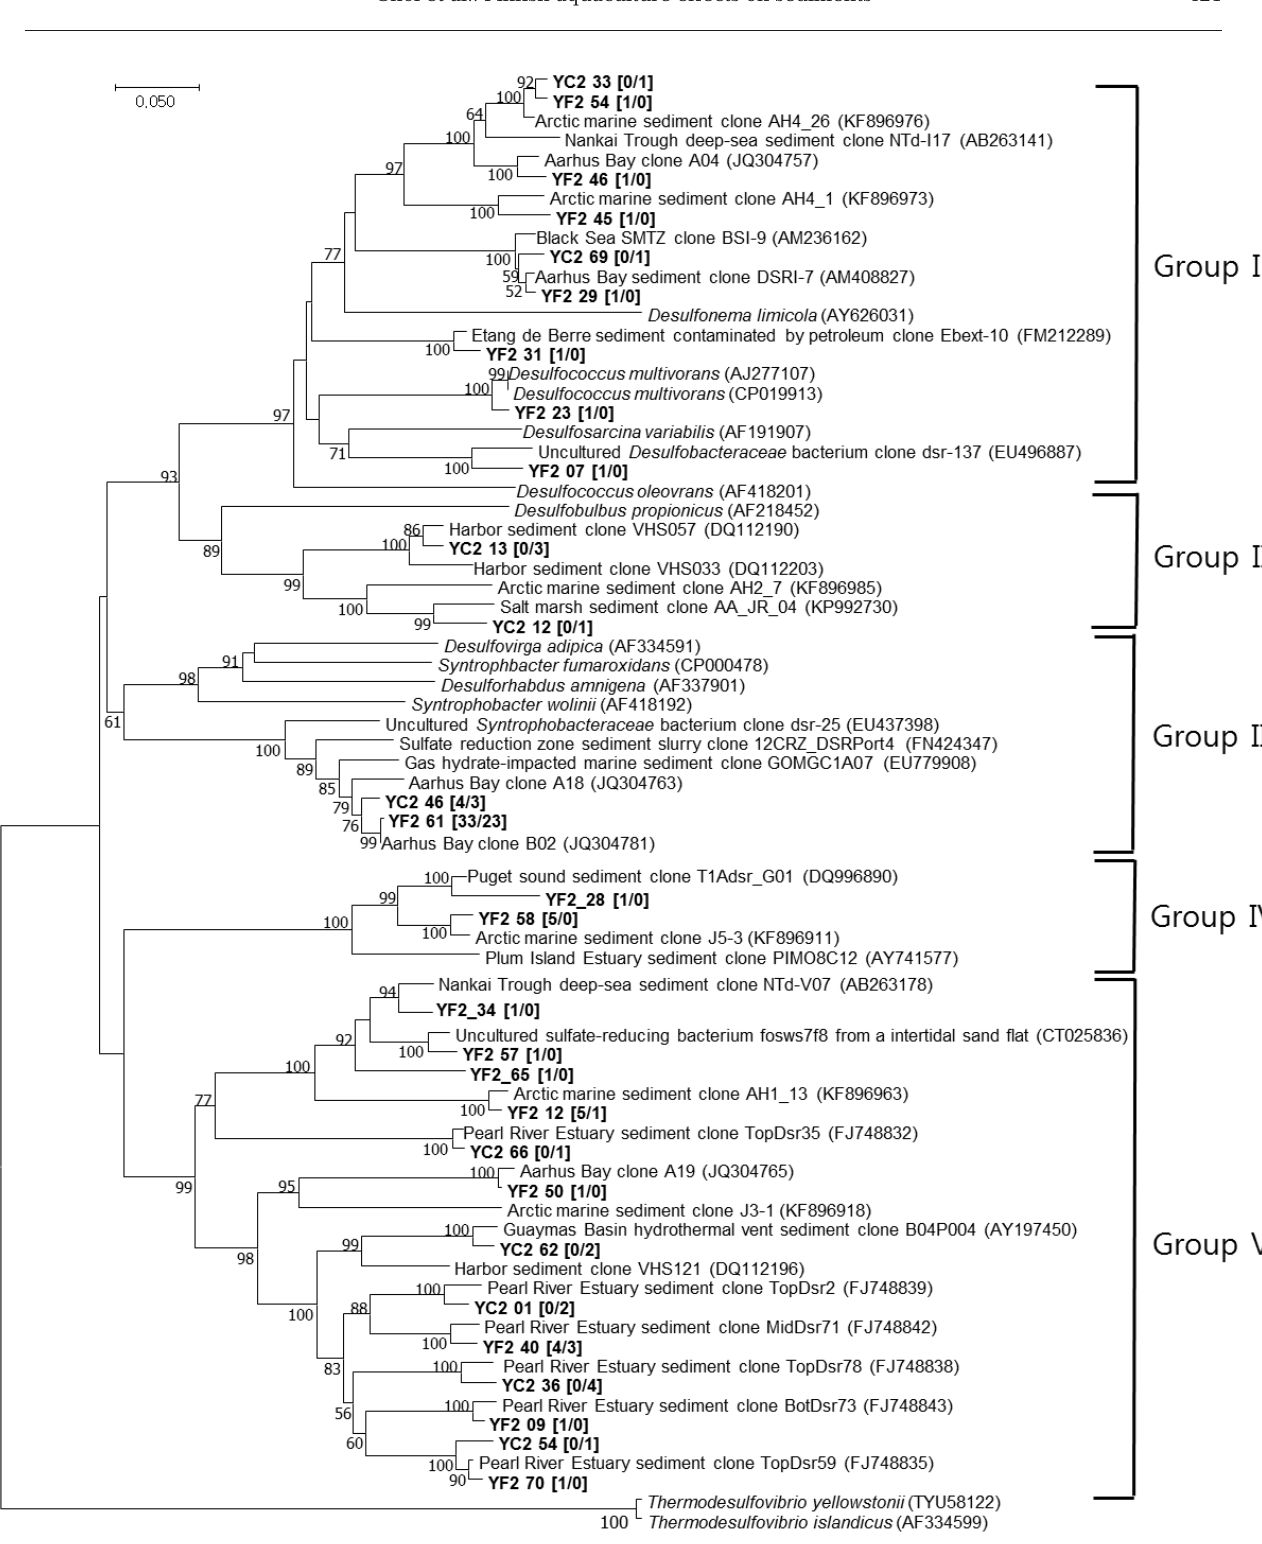
Fig. 4. Phylogenetic tree based on partial sequences of dsrA from sulfate-reducing prokaryotes, including partial sequences based on environmental dsrA gene amplicons. Sequences were retrieved from sediment (1−2 cm depth) of the farm ( YF ) and reference ( YC ). The tree was constructed using the neighbor-joining method with Thermodesulfovibrio yellowstonii and T. islandicus . Bootstrap values are based on 1000 replicates and are indicated at branch nodes for values > 50% bootstrap sup- port. Numbers in square brackets indicate the number of dsrA gene sequences detected from YF and YC. GenBank accession numbers for each sequence are indicated in